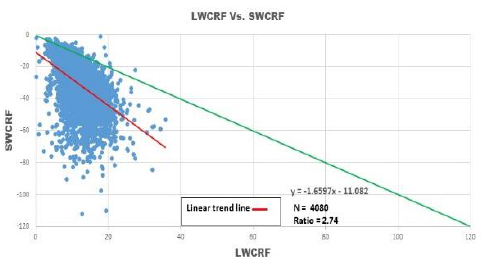
Figure 8. Scatter plot between monthly mean SWCRF (Wm - 2 ), LWCRF (Wm - 2 ) from the CERES at individual grid points over the east coast of Madagascar